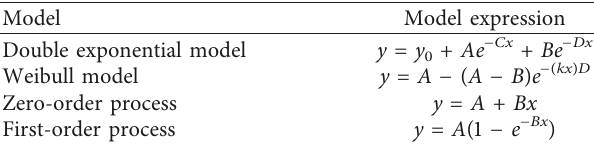
Figure 4: Moisture absorption curve at the temperature of 50 ° C at (a) RH 40%, (b) RH 60%, and (c) RH 80%. Table 2: Model fitting of moisture adsorption kinetics curve.